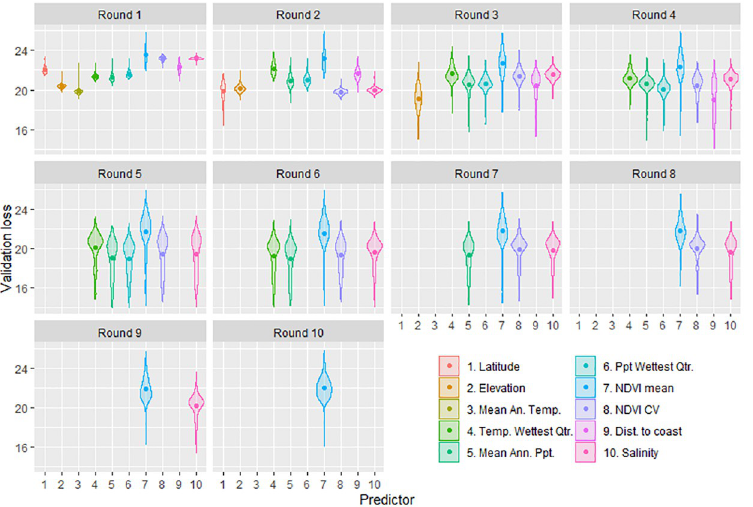
Fig 1. The forward selection process for the neural network model that estimates the relative abundance of the two subspecies. For each round of selection, the validation loss (a measure of how well the model predicts to novel data—lower is better) is shown with a different colour for each predictor. The width of the violin plots reflect the frequency of the validation loss across the 500 individual neural network runs, with the mean shown as a large dot. The forward selection process begins (Round 1) by calculating the validation loss for ten models that each include just a single different predictor. The predictor leading to the “best” model with the lowest mean validation loss is then accepted (Round 1: Mean Annual Temperature). The selection process continues (Round 2), calculating validation loss for nine models including Round 1’s accepted predictor, and one new predictor. Similarly, the predictor leading to the best model is then accepted (Round 2: Latitude). This process is repeated until accepting a new predictor no longer improves the model. In our analysis, the selection process stopped after Round 4. https://doi.org/10.1371/journal.pcbi.1009526.g001 Fig 2 shows the final estimated relative abundance as a mean of 100 neural network model runs using the chosen variables, alongside the standard deviation of these runs. The relative abundance follows a similar pattern to that of [27], with An. gambiae s.s. mostly dominant except in some coastal areas and towards the Sahel. As expected, the variance between model